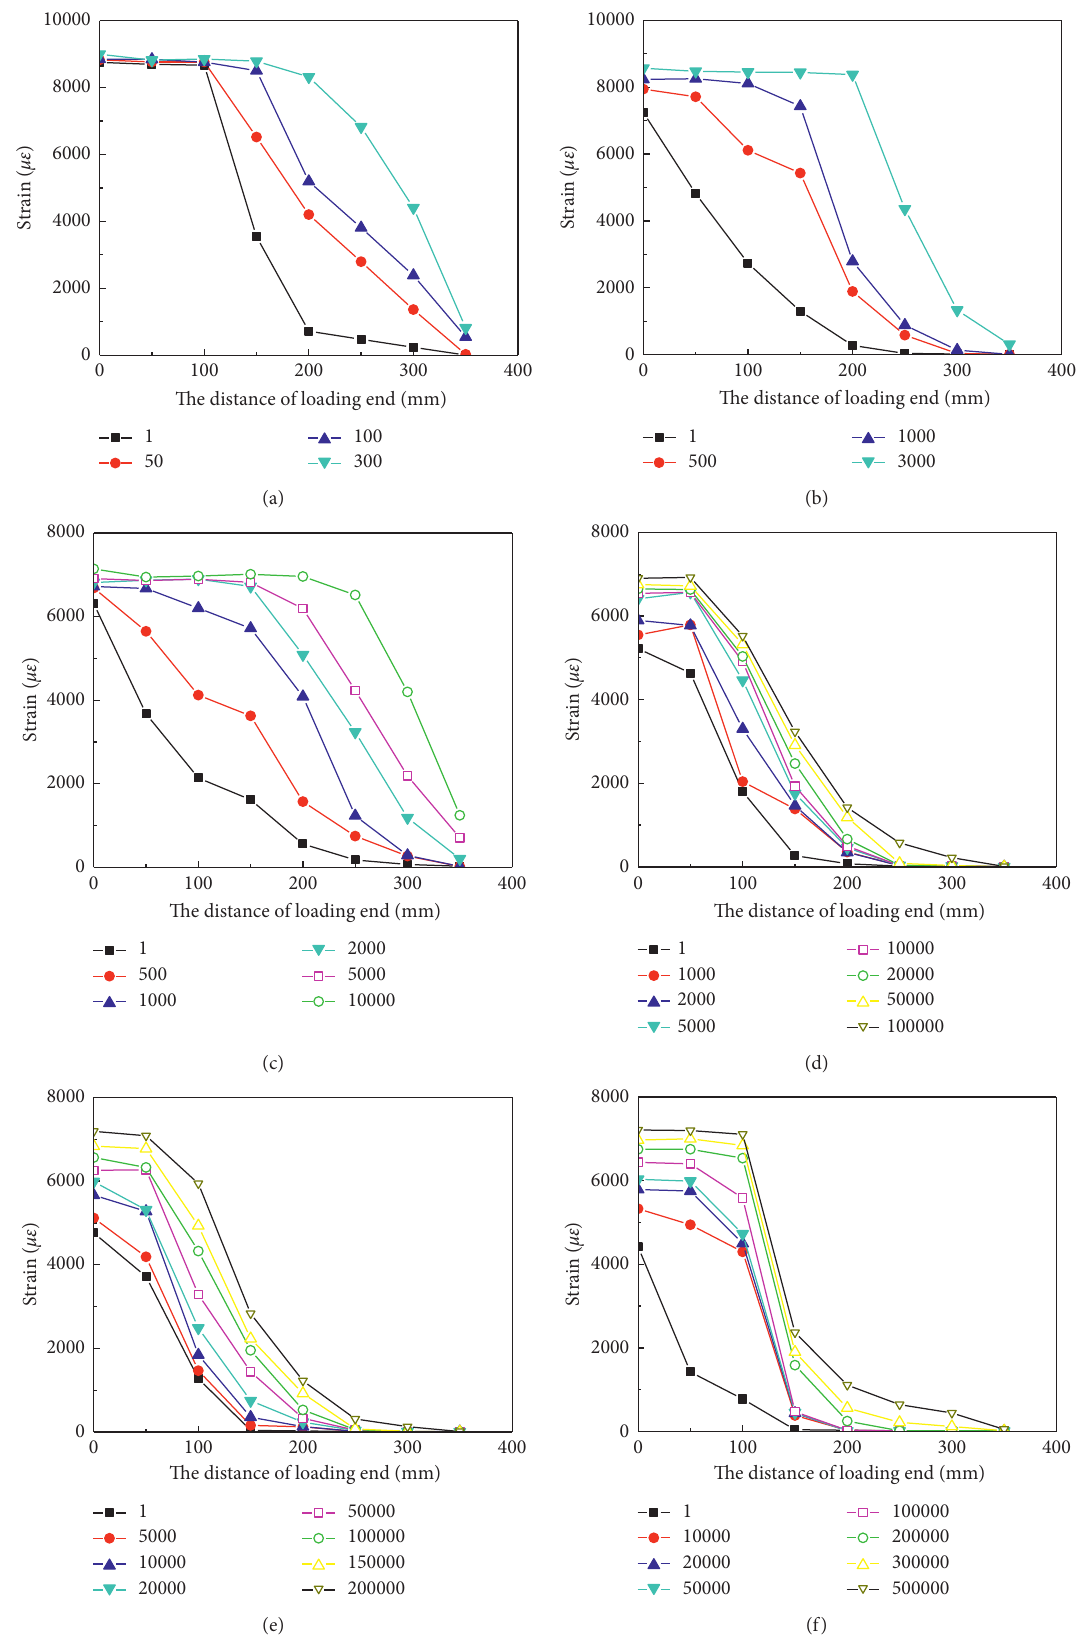
Figure 11: Distribution of BFRP grid strain as a function of bonding length under fatigue loading. (a) F-1. (b) F-2. (c) F-3. (d) F-4. (e) F-5. (f)